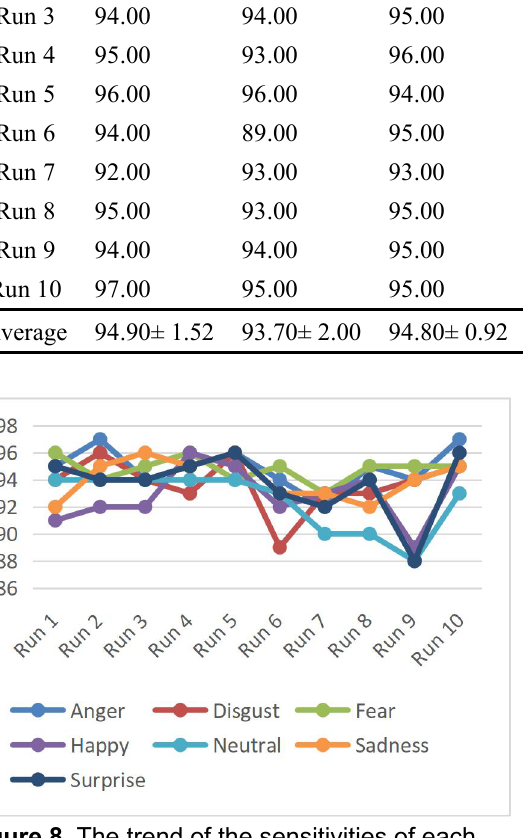
Figure 9. Overall accuracy